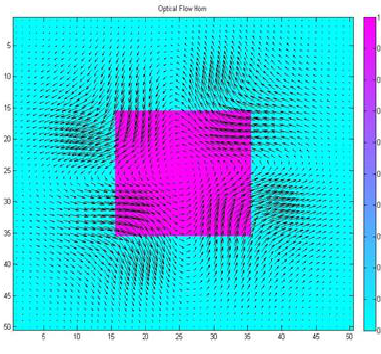
Figure 8. Results of Horn/Schumck (α=3)